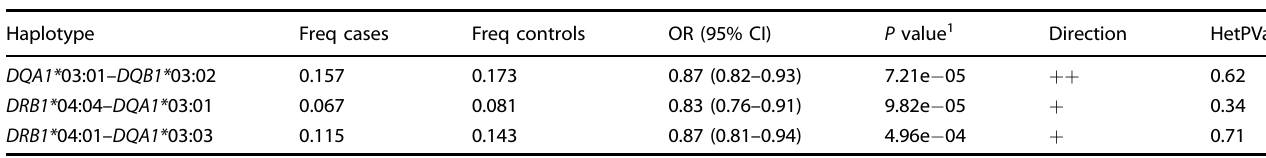
Table 2. Meta-analyses of HLA haplotype association.